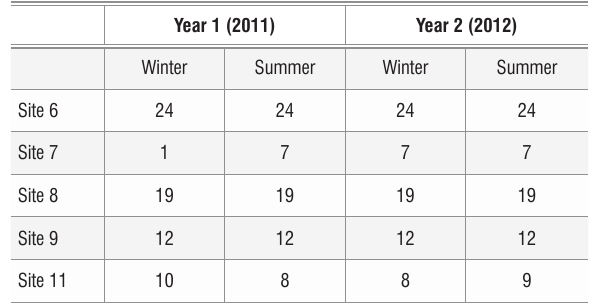
Number of samples per site, season and